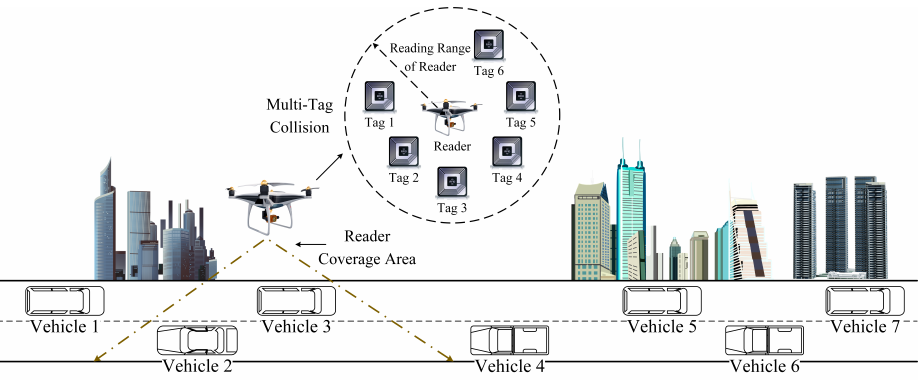
Figure 1. A RFID-integrated framework in UAV-aided